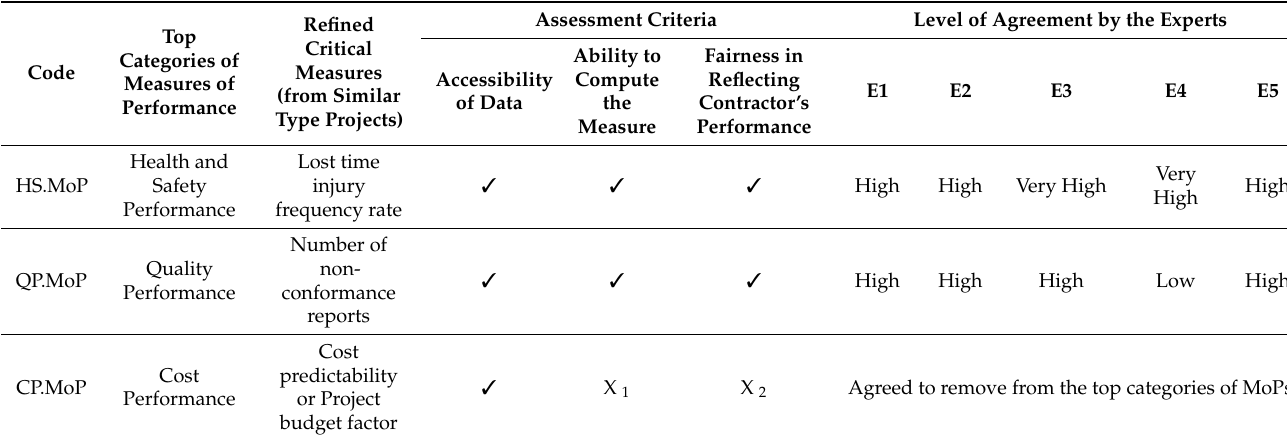
Table 5. Shortlisting of the top categories of measures of